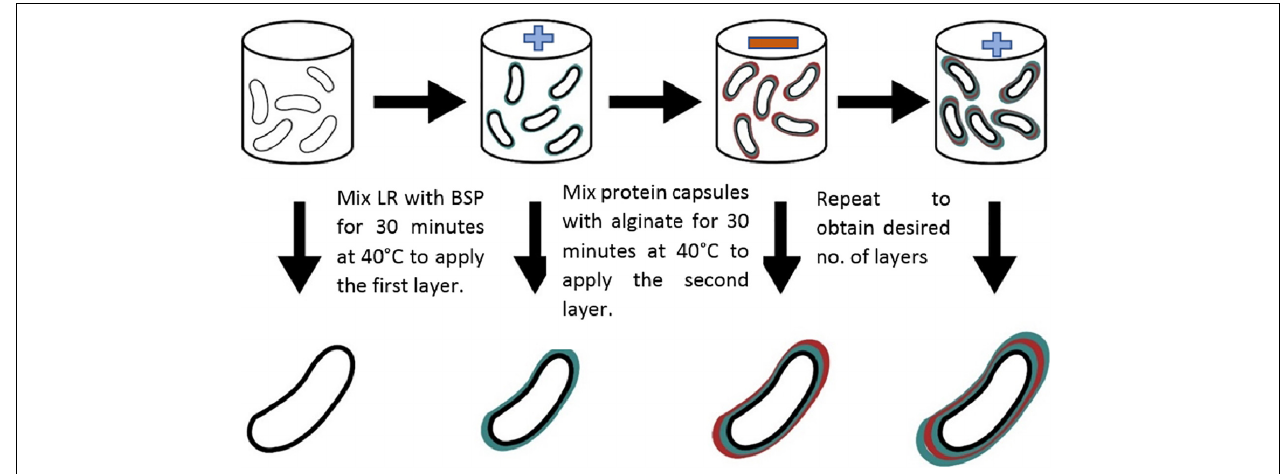
FIGURE 1 | Layer-by-layer procedure to coat L. rhamnosus cells. Plain cells were mixed with BSP to apply first positively charged layer, a polysaccharide layer (alginate, glucomannan, inulin) was applied as second negative layer followed by a third layer of B SP.